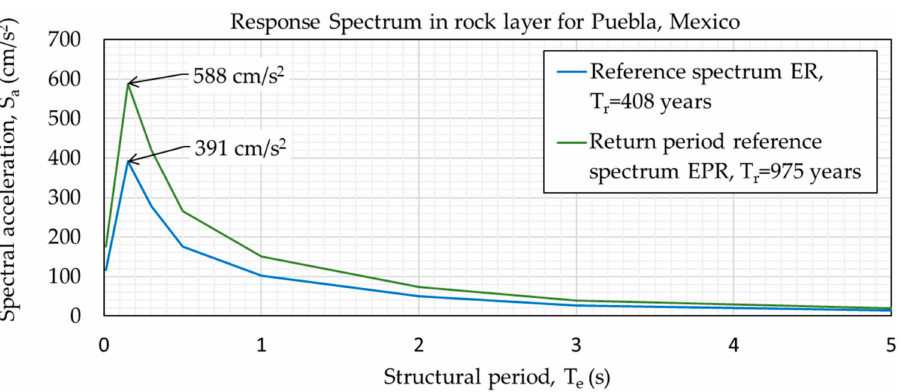
Figure 3. Seismic spectra results obtained from PRODISIS software for the city of Puebla, Mexico.